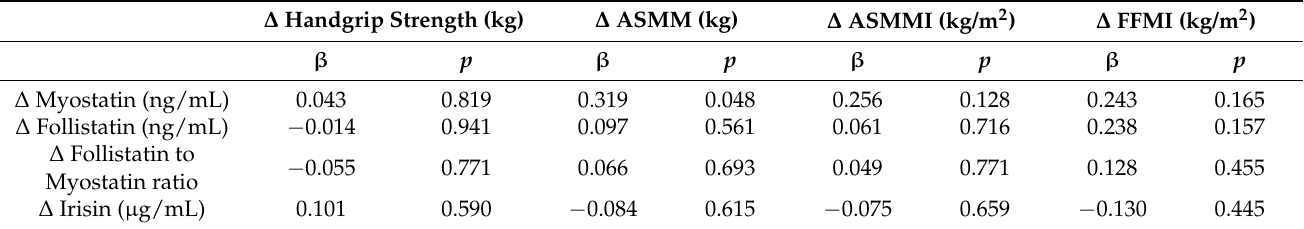
Table 3. Associations of changes in myokines with changes in muscle mass parameters after the